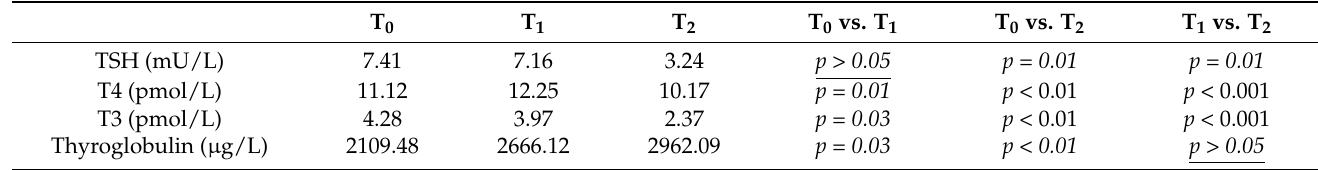
Table 4. Mean levels of TSH, T4, T3, and thyroglobulin perioperative in subgroup II ( n = 17). T 0 T